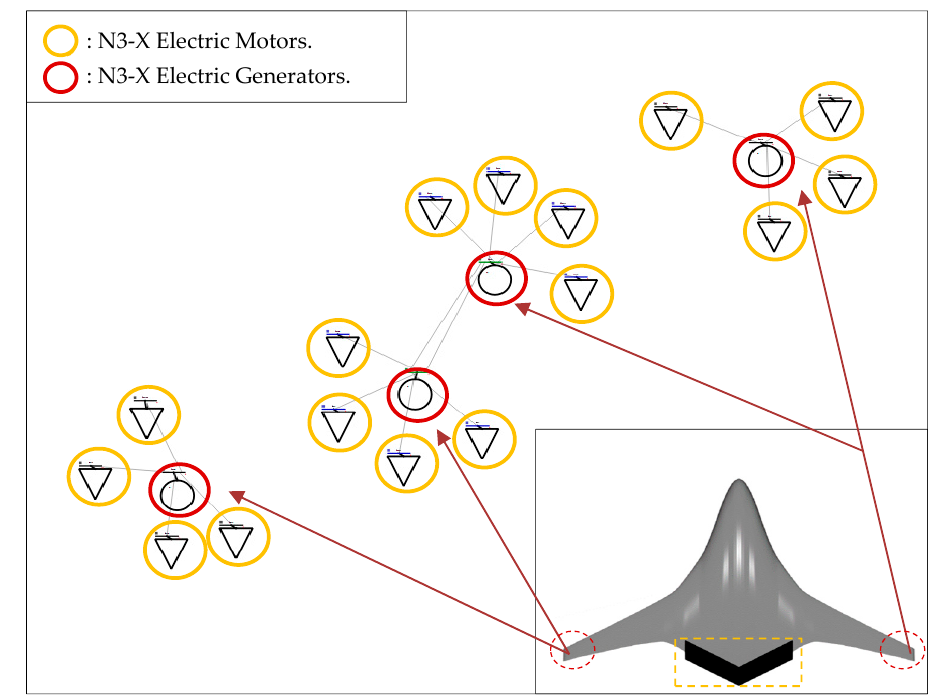
Figure 6. NASA N3-X model on GridMatch.